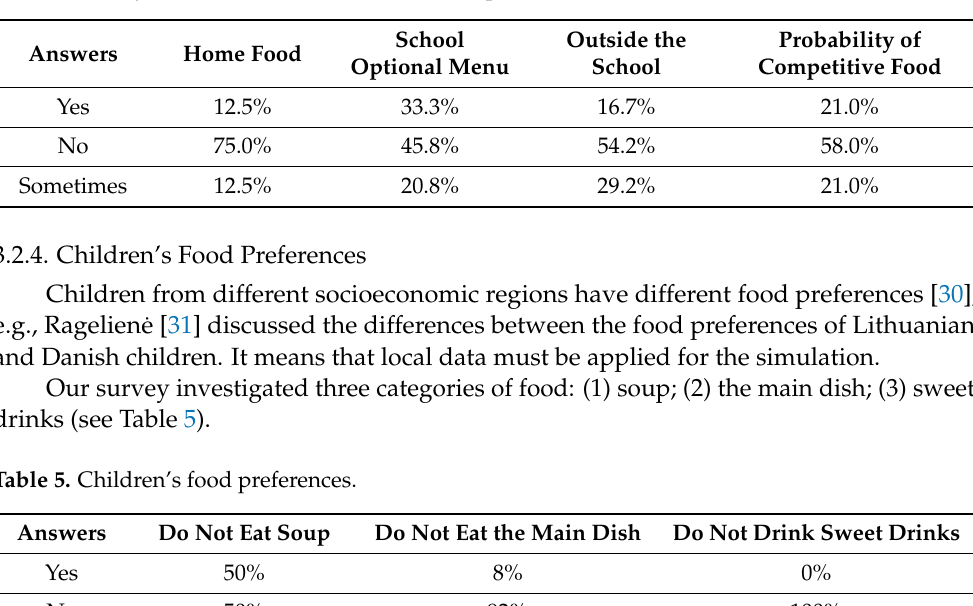
Table 5. Children's food preferences.